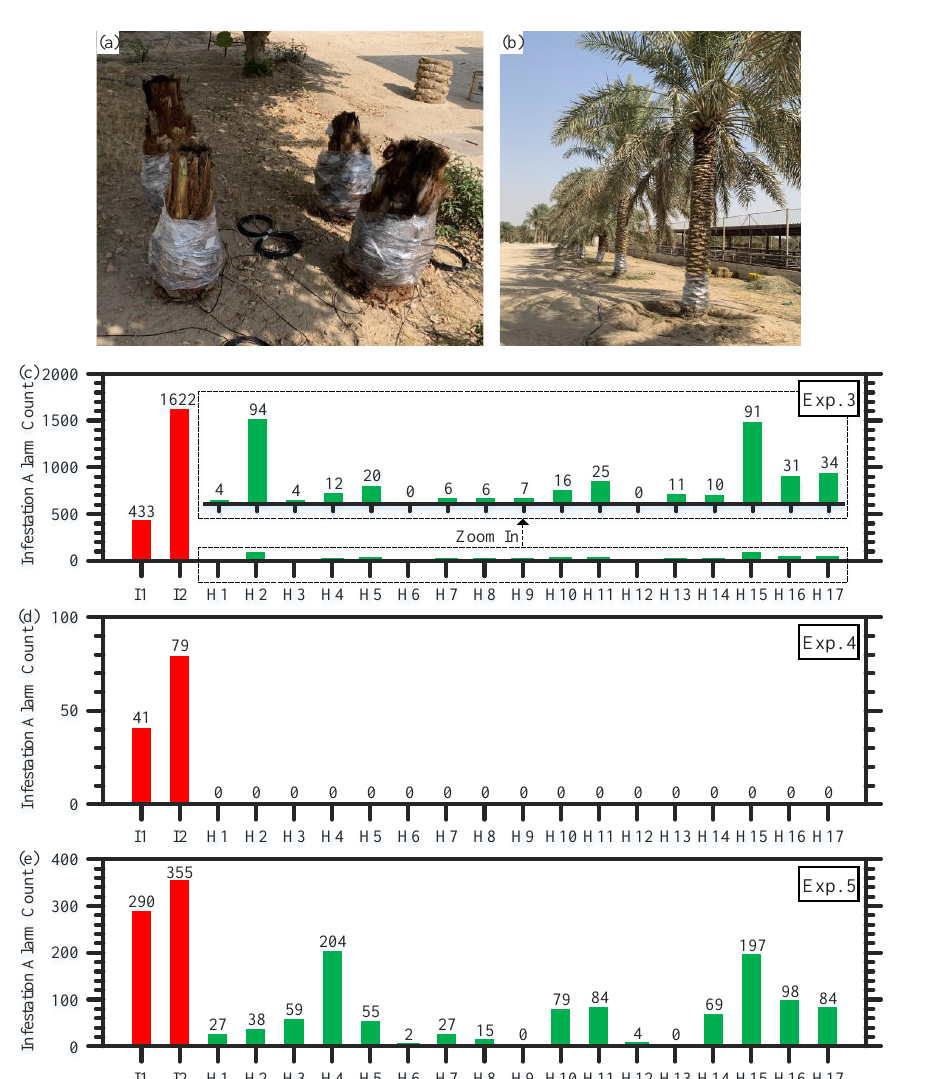
Figure 6. In the outdoor farm, there are two short infested and two short healthy trees ( a ), and another 15 tall typical trees ( b ). Infestation alarm count produced by our sensor during Exp. 3 ( c ), Exp. 4 ( d ), and Exp. 5 ( e ). I: infested tree; H: healthy